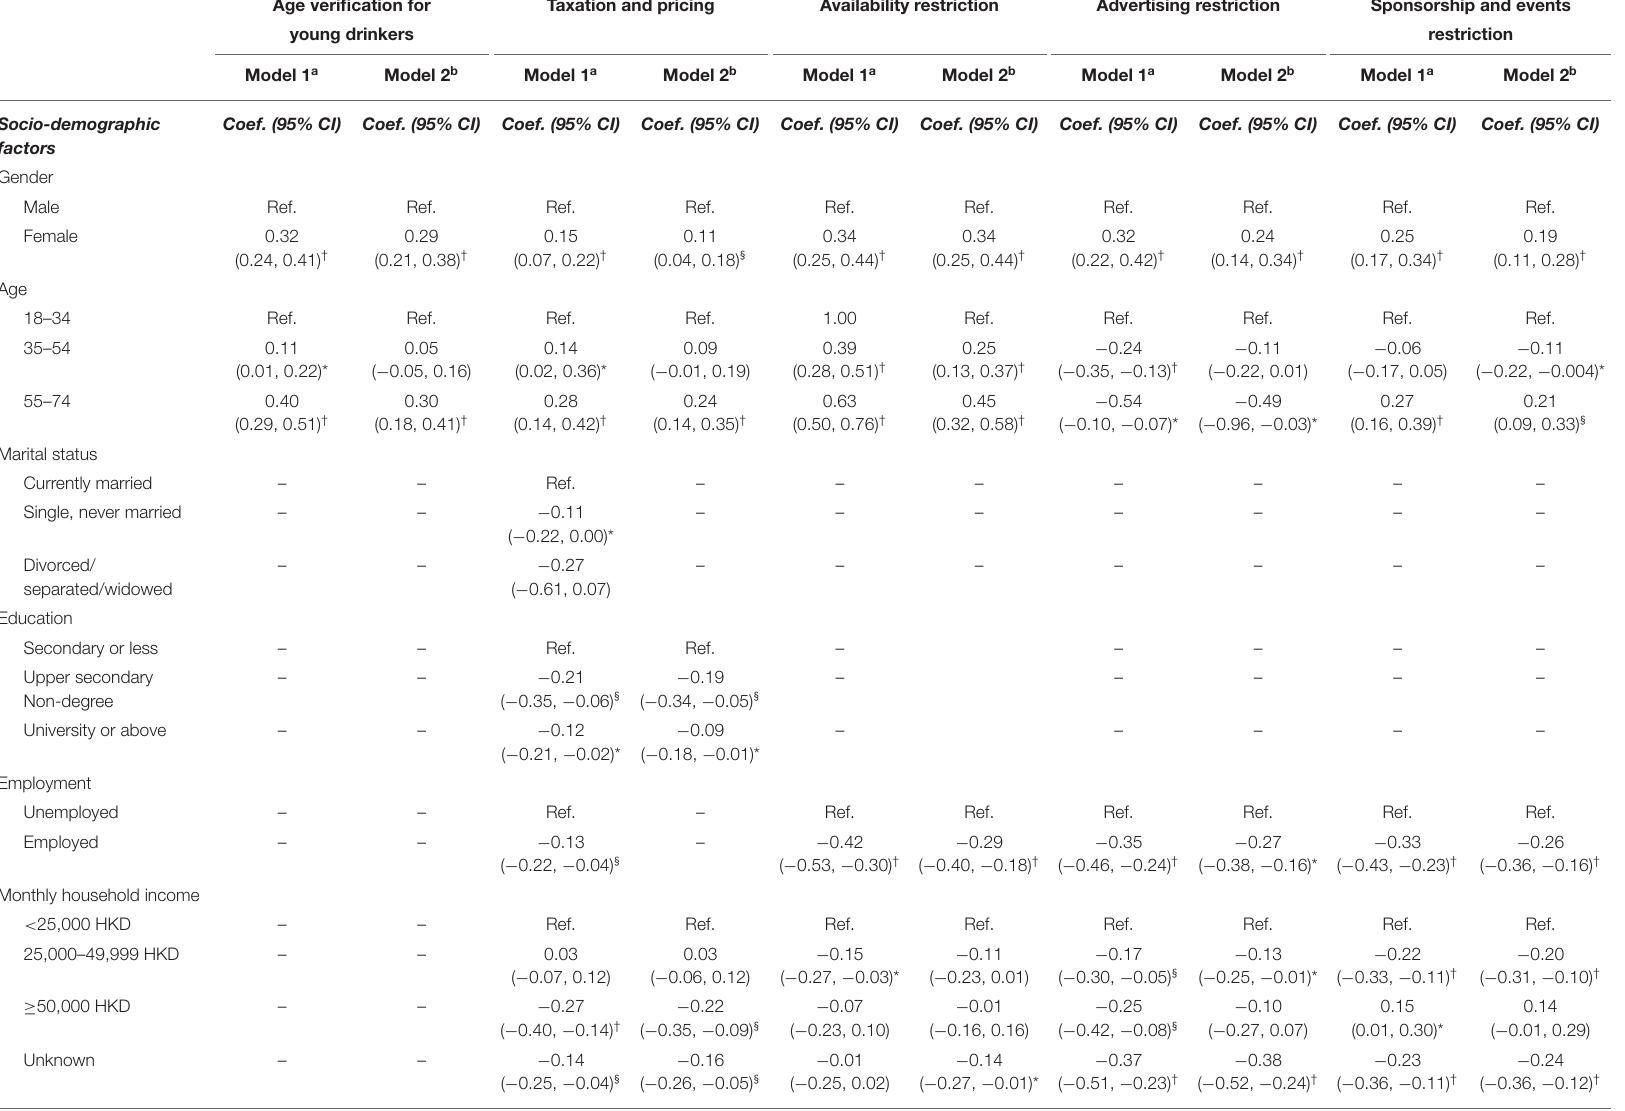
TABLE 4 | Socio-demographic, attitudinal, and drinking-related factors associated with endorsement of alcohol harms reduction strategies measured by PC